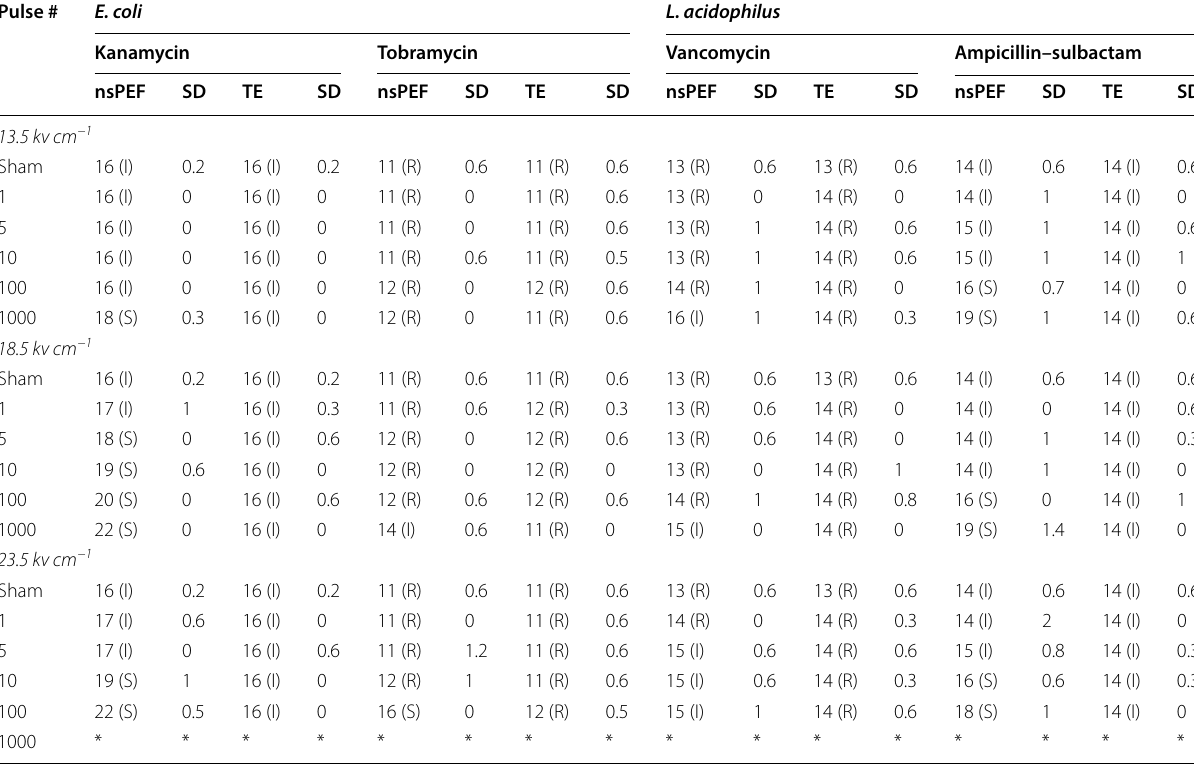
Table 1 Zones of growth inhibition for E. coli and L.